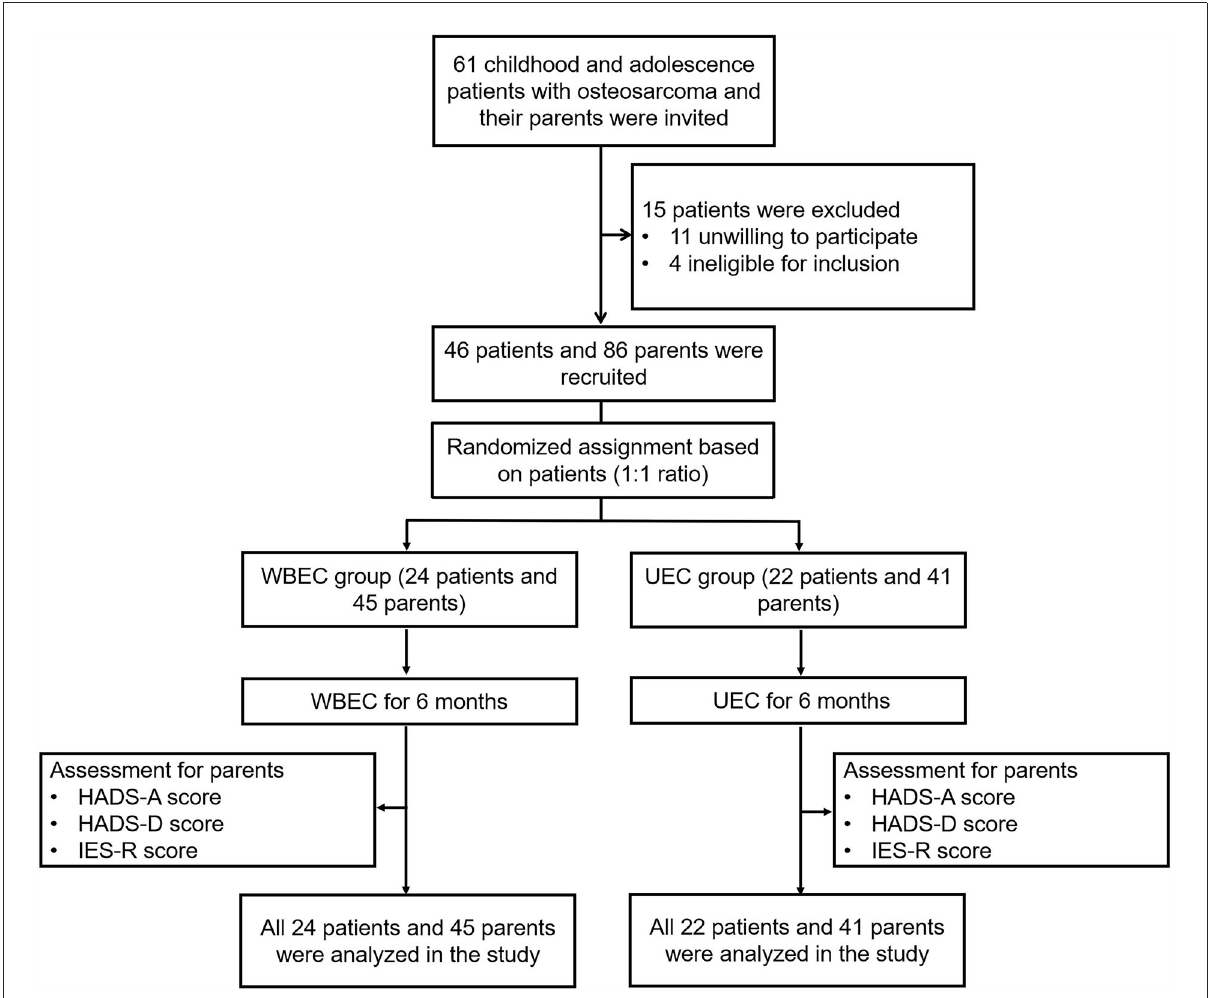
FIGURE1 Flowchart. WBEC, WeChat-platform-based education and care program; UEC, usual education and care program; HADS-A, Hospital Anxiety and Depression Scale for anxiety; HADS-D, Hospital Anxiety and Depression Scale for depression; IES-R, Impact of Event Scale-Revised.